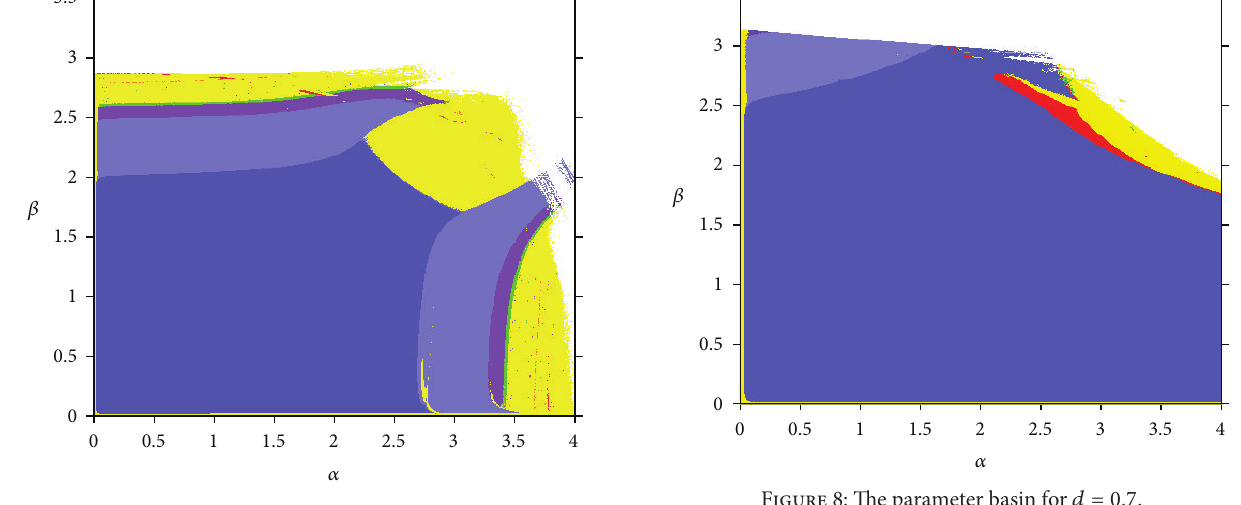
Figure 6: The parameter basin for 𝑑 = 0.3 .